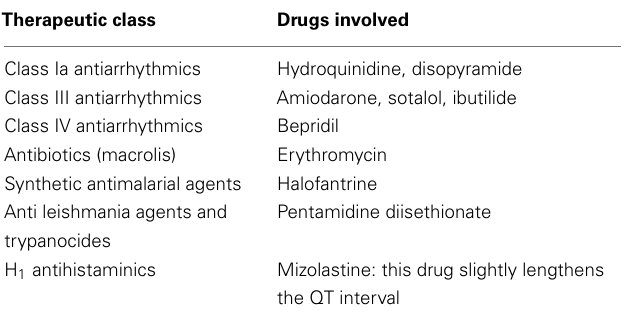
Table 6 | Drugs that may prolong the QT interval. Table 7 | Drugs responsible for hypokalemia.